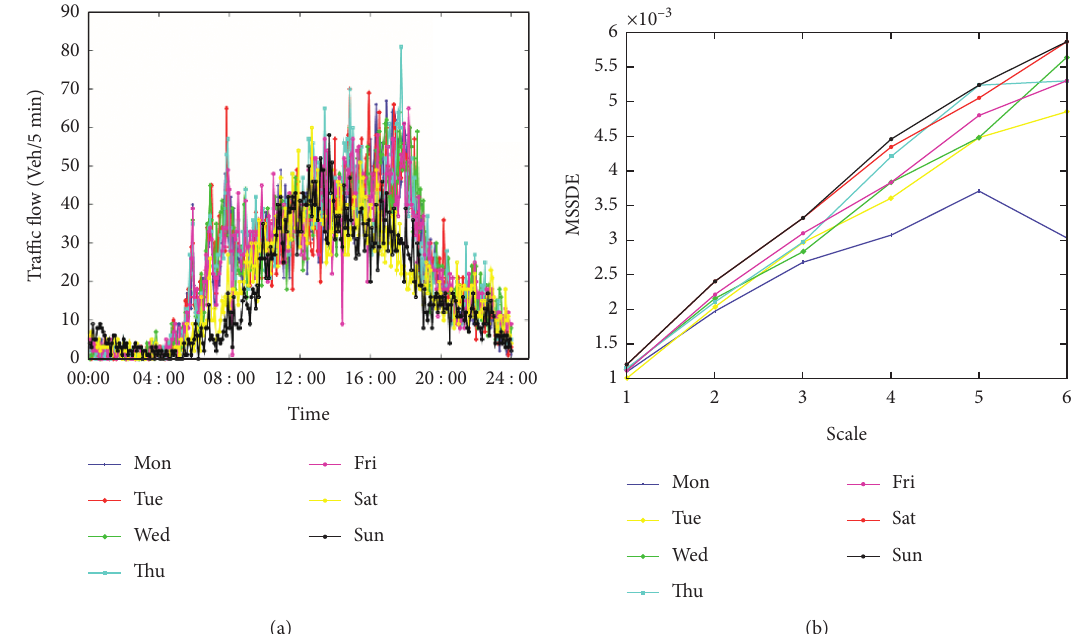
Figure 7: The result of traffic data collected by detector 5562. (a) The traffic data collected of week model from Monday to Sunday. (b) The result of analysis on the traffic day using the proposed MSSDE.